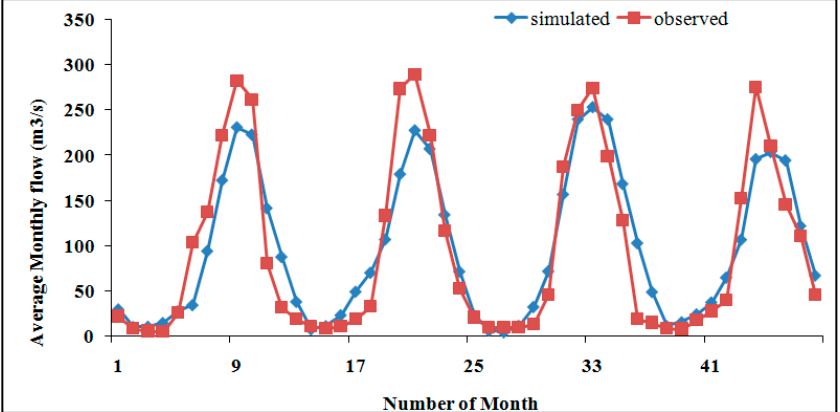
Figure 12. Simulated and observed flow during the validation period (2005–2008).